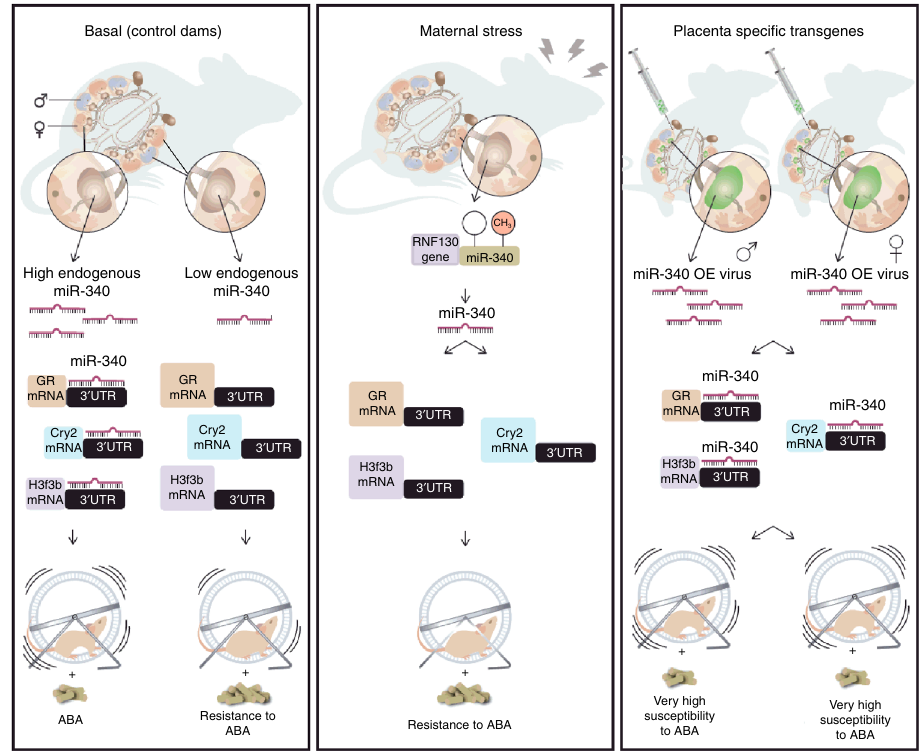
Fig. 7 Summary scheme comparing placental miR-340 expression and the adult outcome in the different experiments. Female offspring born from control dams present high levels of placental miR-340, while the male levels are endogenously low. MiR-340 targets Nr3c1 / GR , Cry2 , and H3f3b programming susceptibility to activity-based anorexia (ABA) speci fi cally in females (left panel). Prenatal stress downregulated miR-340 through gene-body DNA methylation, upregulating Nr3c1 / GR , Cry2 , and H3f3b , thus are protecting the female offspring from sensitivity to ABA (central panel). Upregulation of placental miR-340 through lentiviral infection of blastocysts reduced GR/CRY2/H3F3b protein levels, and robustly increased ABA susceptibility in both sexes (right panel). CV control virus, GR glucocorticoid receptor, OE